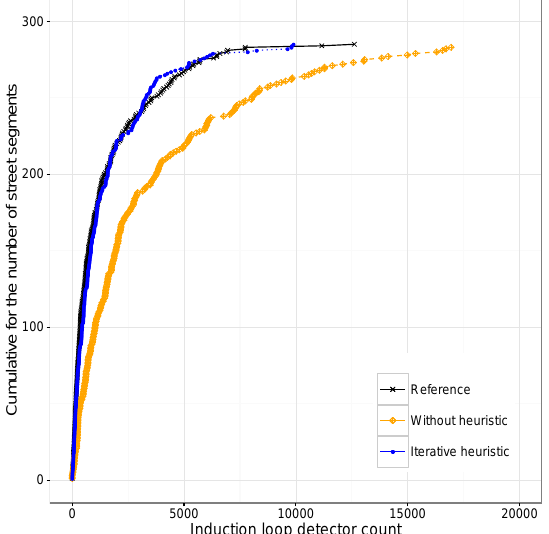
Figure 1. Traffic flow modeling for Valencia. Results with and without our iterative heuristic